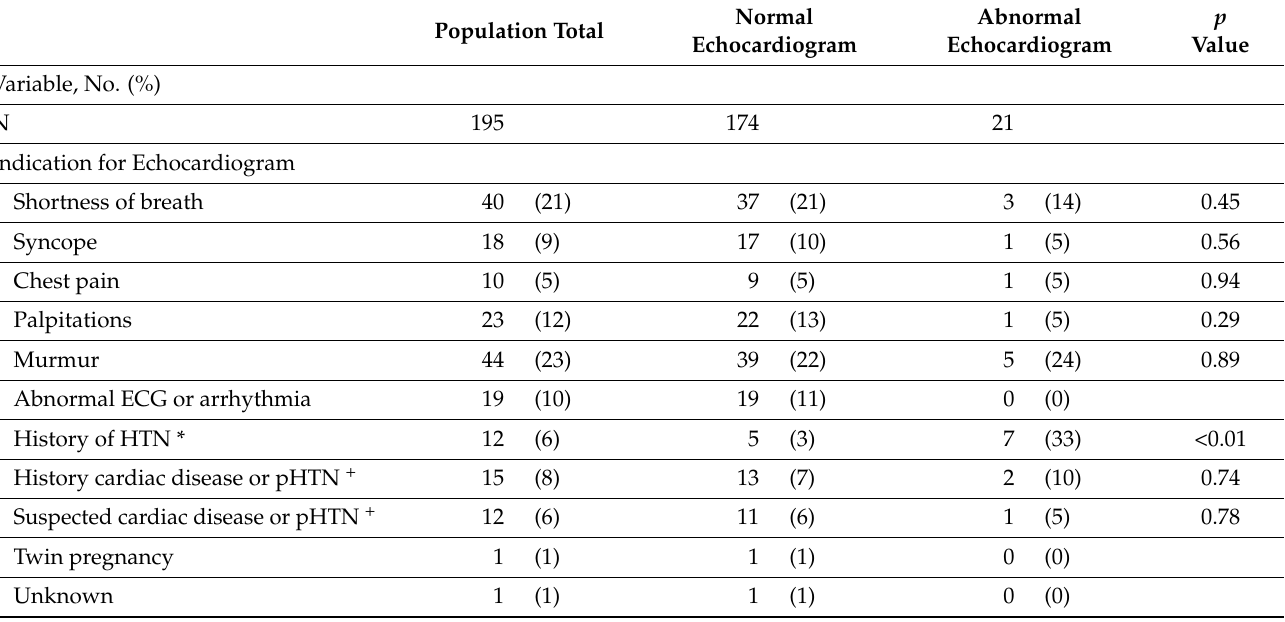
Table 2. Indications for echocardiography among low-risk pregnant